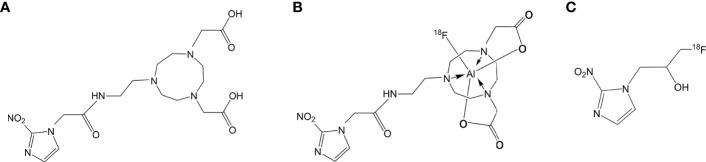

(A) Structures of NOTA-NI. (B) Structures of Al18F-NOTA-NI. (C) Structures of 18F-MISO.